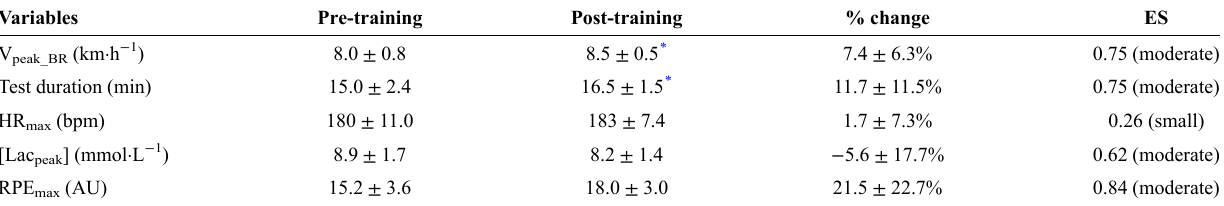
Table 2 - Physiological and performance variables obtained during the incremental test for V peak_BR determination at pre- and post-training (mean ± SD) (n = 8).